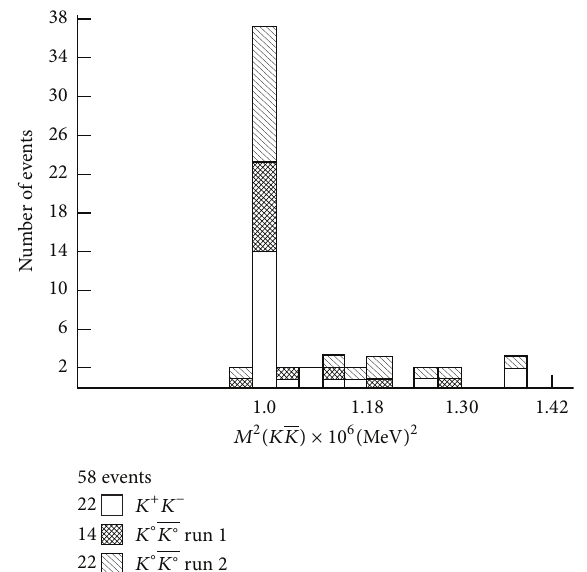
Figure 1: Number of events versus square of invariant mass of 𝐾𝐾 pairs from the reaction 𝐾 + 𝑝 → Λ + 𝐾 + 𝐾 in bubble chamber experiments at Brookhaven National Laboratory (BNL)